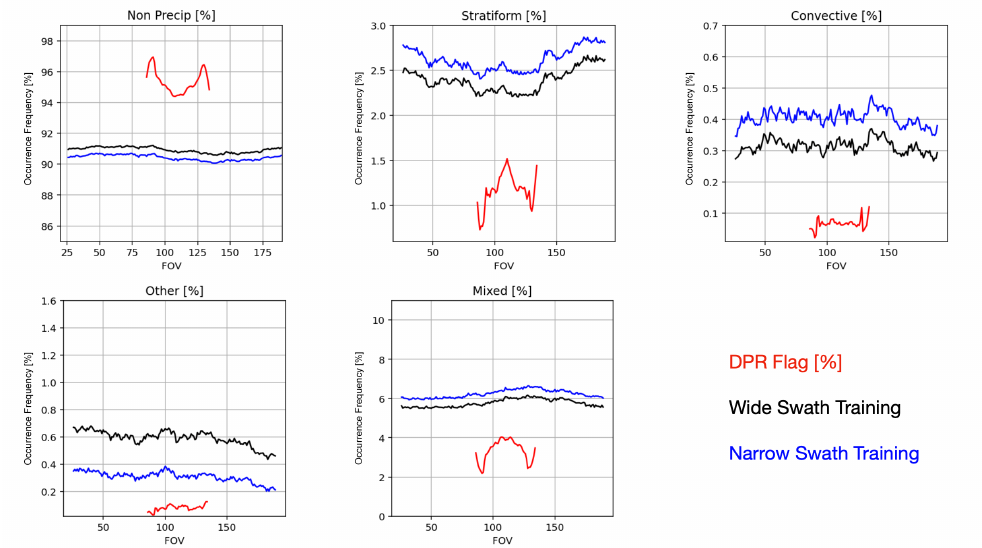
Figure 6. The view-angle dependency of occurrence frequency of each precipitation type from DPR (red), wide-swath training result using GB+emis model (black), and narrow-swath training result using GB+emis model (blue).